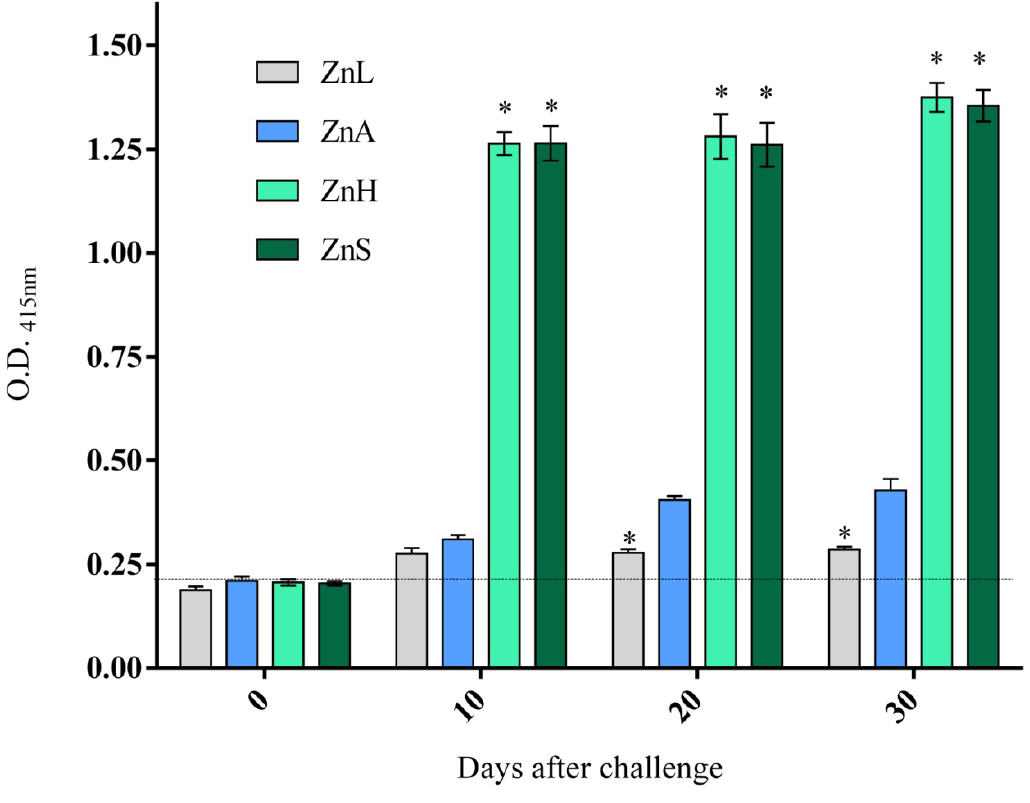
Figure 3. Time-course of parasite-specific IgG antibody response in CD-1 mice after oral immunization with 5 × 10 6 G. lamblia trophozoites. The horizontal dotted line indicates the mean optical density plus two fold standard deviation at 415 nm (O.D. 415 nm) for the negative control and the group of non-infected mice, which represents the cutoff point for positivity of the ELISA. Results are expressed as means ± S.D. from three measurements, each containing pooled sera from 8 to 10 mice. * Significantly different from ZnA mice at each time-point, p <